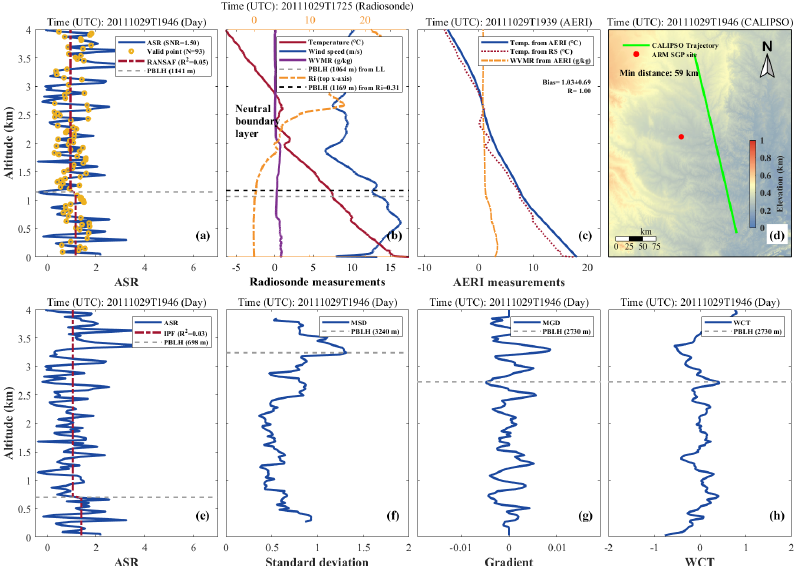
Figure 12. ASR was measured using CALIOP at 19:46:46 UTC (day) on 29 October 2011; PBLHs were determined by using the ( a ) RANSAF, ( b ) radiosonde (RS), ( e ) IPF, ( f ) MSD, ( g ) MGD, and ( h ) WCT methods; ( c ) vertical profile of temperature and water vapor mixing ratio (WVMR) retrieved from AERI with the red dotted line refer to the temperature measured by RS in ( b ), Bias (R) is the mean difference (correlation coefficient) between temperature profiles from AERI and RS; ( d ) ARM SGP site of radiosonde observations and CALIPSO trajectory. The minimum distance between the CALIOP and radiosonde (AERI) measurements are shown at the top of subfigure ( d ).